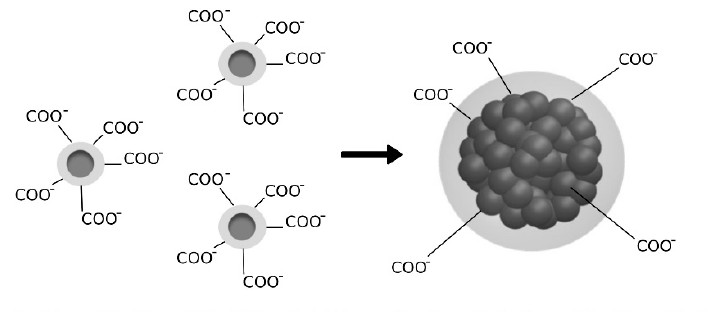
Figure 1. Formation reaction and structure of aggregated nanoparticles coated with succinic acid.